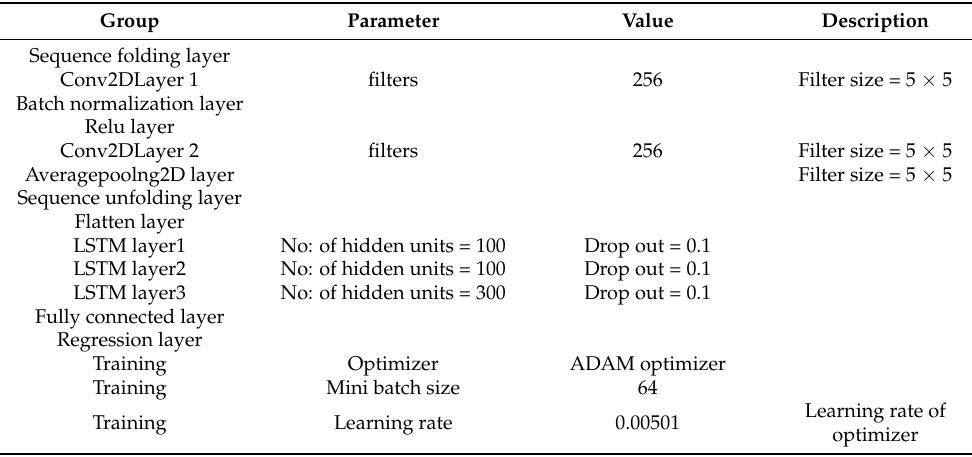
Table 3. The architecture of the proposed multi step-CNN stacked LSTM network.